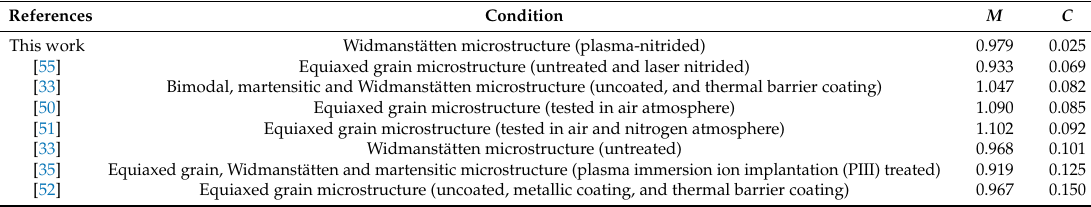
Table 6. Values of the constants M and C for the Monkman–Grant relationship.